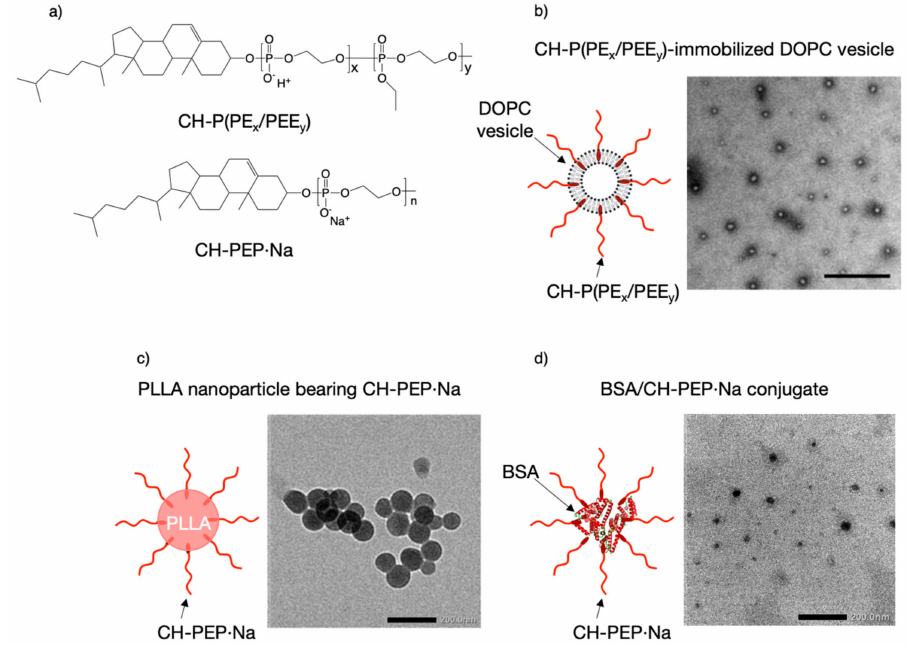
Figure 5. ( a ) Chemical structure of amphophilic PPDEs. ( b ) Amphiphilic polyphosphodiester copolymer [CH-P(EP x / EEP y )]-immobilized 1,2-dioleoyl-sn-glycero-3-phosphocholine (DOPC) vesicles. Scale bar represents 500 nm. ( c ) Poly L-lactic acid nanoparticles bearing amphiphilic poly(ethylene sodium phosphate) (CH-PEP · Na). Scale bar represents 200 nm. ( d ) Bovine serum albumin / CH-PEP · Na conjugates. Scale bar represents 200